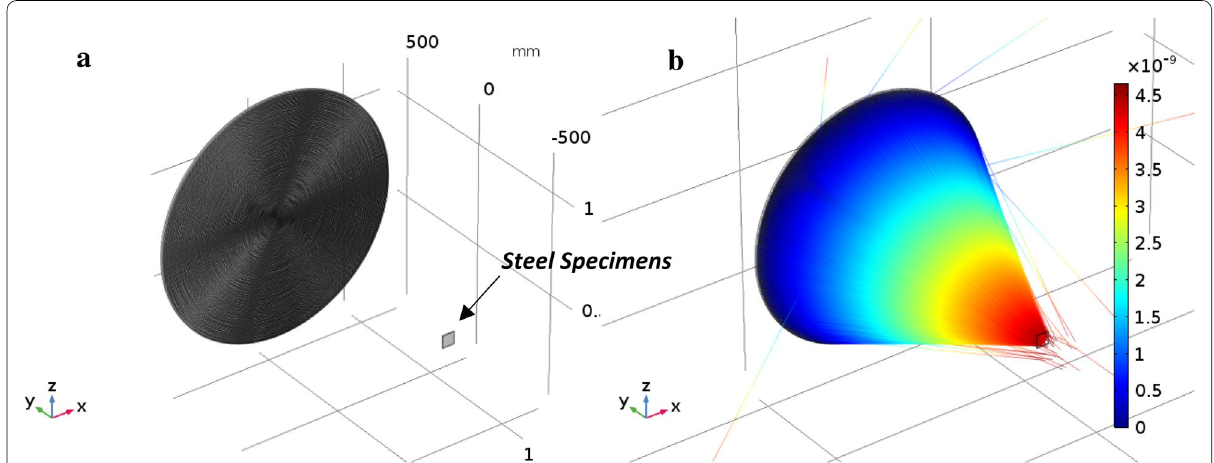
Fig. 6 Solar welding application ray tracing. a Fresnel concentrator setup in COMSOL ® , b ray trajectories at the specimens’ plane from ray-tracing simulation of solar